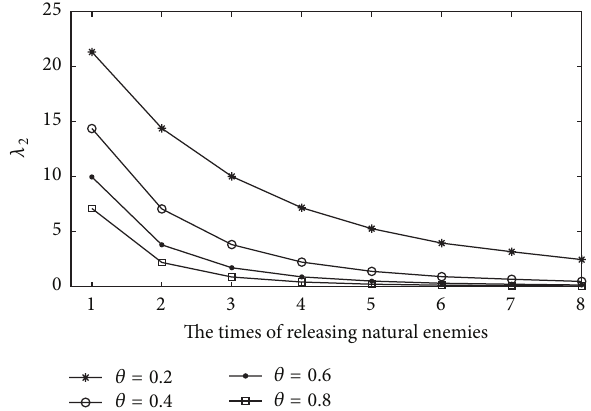
Figure 7: The effects of times of releasing natural enemies and releasing constant 𝜃 on the threshold level 𝜆 2 . The parameter values are as follows: 𝛿 1 = 0.92 , 𝛿 2 = 0.93 , 𝛿 3 = 0.92 , 𝜇 = 0.99 , 𝑇 1 = = 0.8 , and 𝛼 = 0.7 5 , 𝑑 = 0.25 , 𝑟 = 1.2 , 𝑐 = 0.3 , 𝑎 1 2